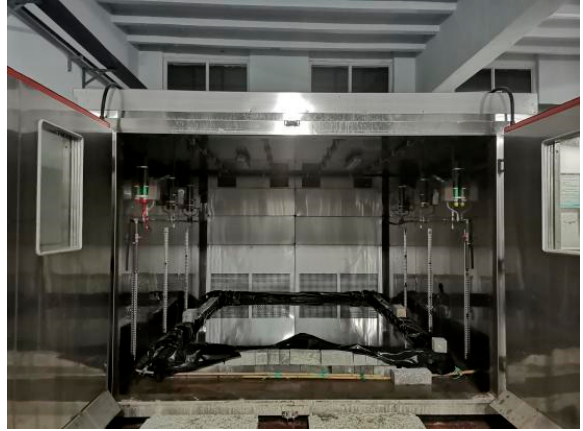
Figure 1. Environmental chamber.